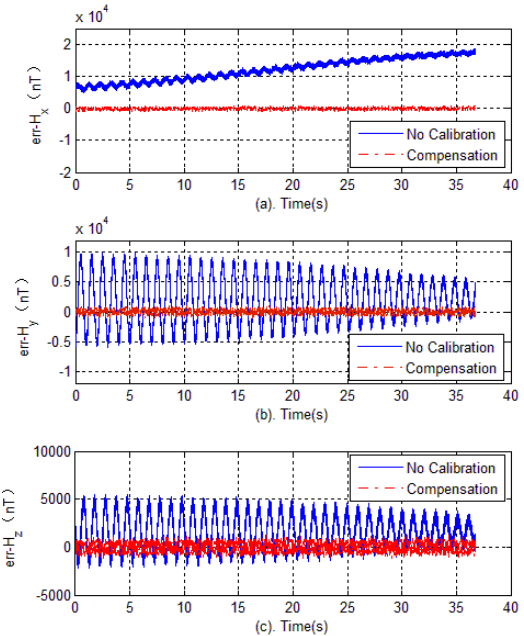
Figure 20. Magnetometer outputs of X-axis. Figure 21. Magnetometer outputs of Y-axis.